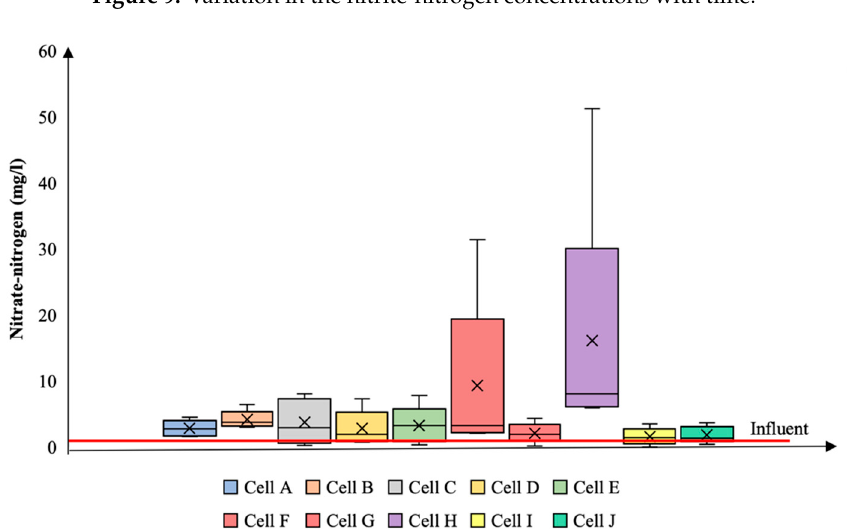
Figure 10. Concentration of nitrate-nitrogen. Sample number = 5; box plots show medians and 25th and 75th percentiles; whiskers represent the 10th and 90th percentiles.